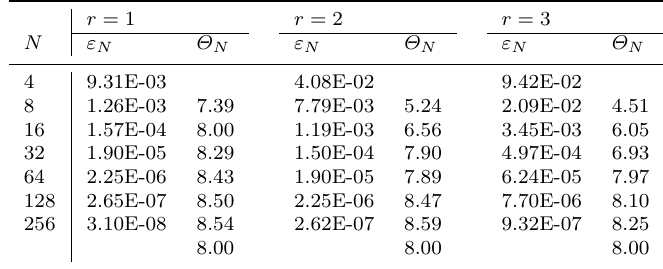
Table 4. Numerical results for problem (5.10)–(5.11) with m = 2. r = 1 r = 2 r = 3 N ε N Θ N ε N Θ N ε N Θ N